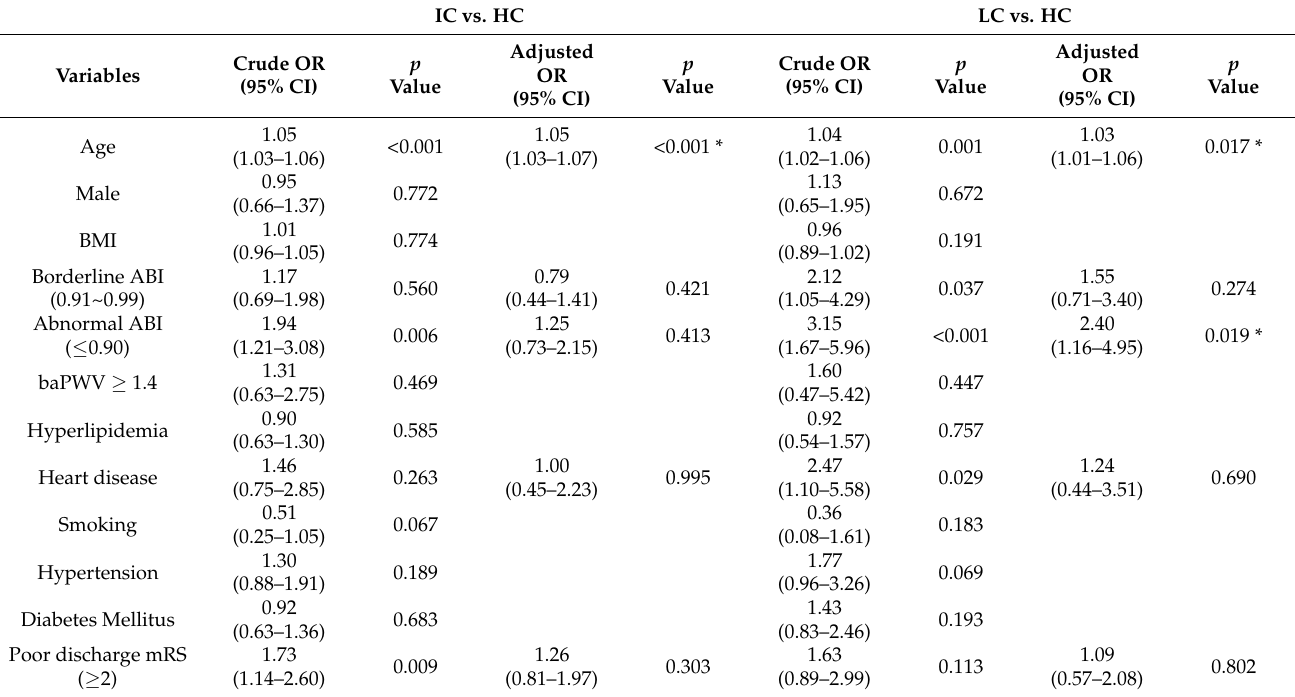
Table 2. Predictors of poor poststroke renal function trajectory by multinomial logistic regression (HC as a reference